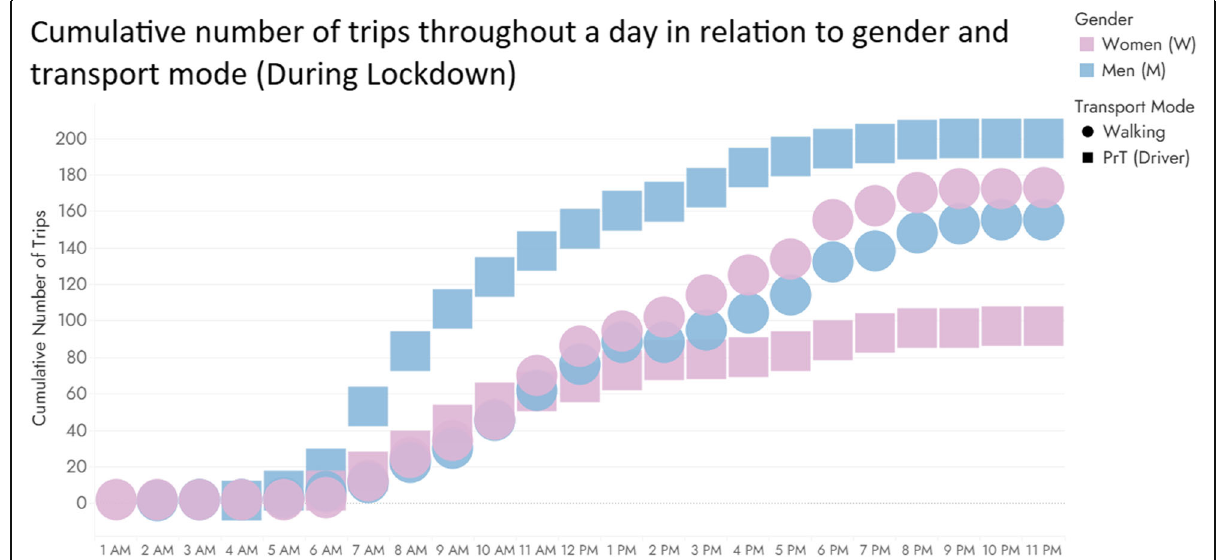
Fig. 6 Cumulative number of trips throughout a day in relation to gender and transport